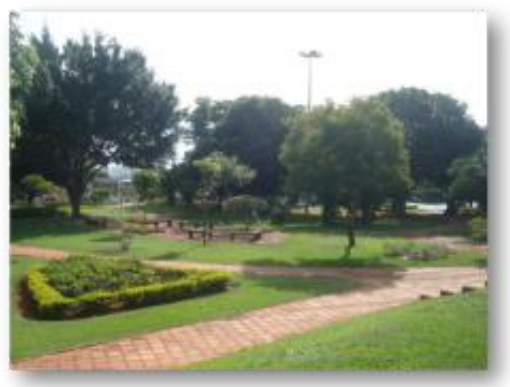
Figure 18 – Small Change in the Central